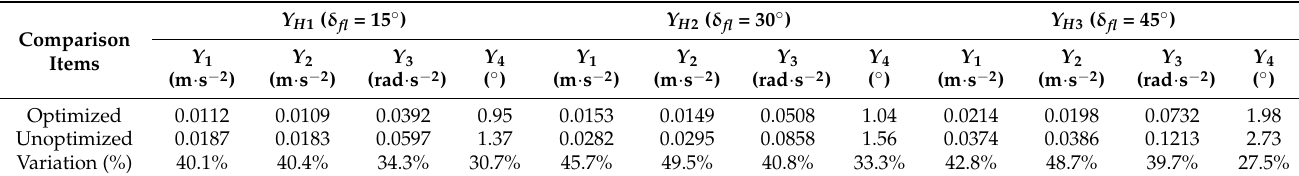
Figure 9. Test scenes of the four-wheel-steering MMS: ( a ) Preparation mode; ( b ) Four-wheel steering. Table 4. Comparisons of MMS effects under optimized and unoptimized control parameters.